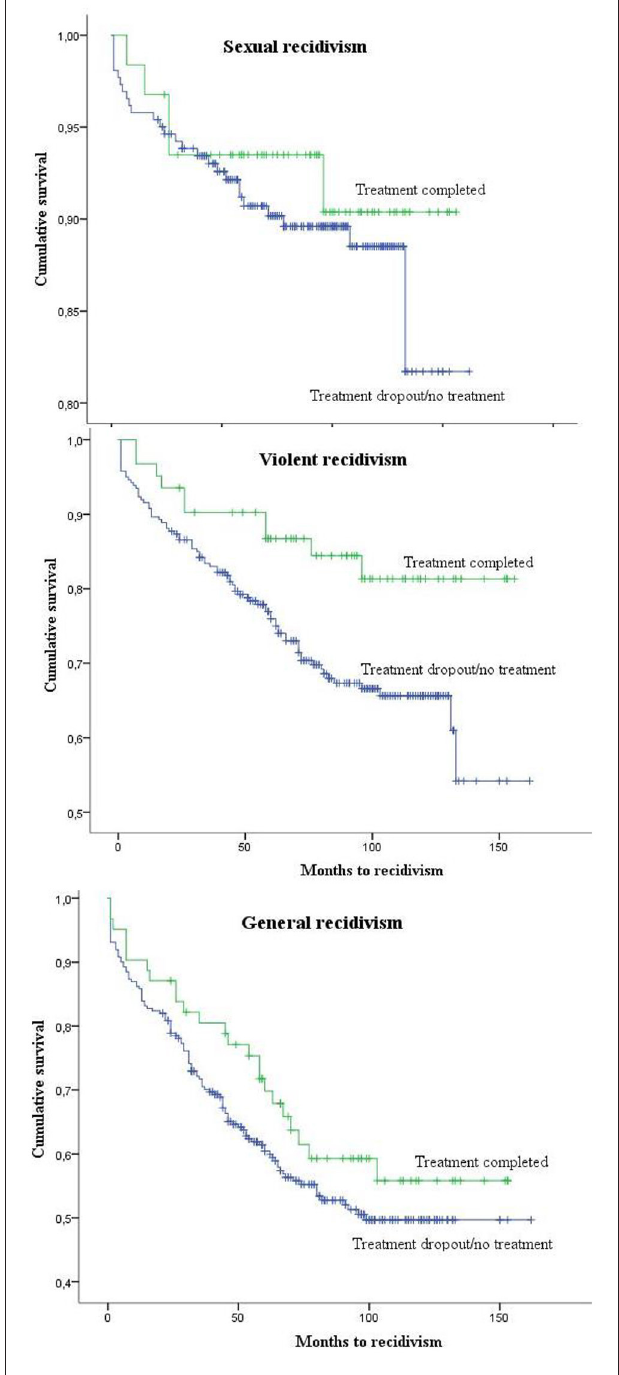
FIGURE 1 | Kaplan-Meier survival curve estimates for sexual, violent (including sexual) and general recidivism by the treatment completed group and the dropped out/no treatment